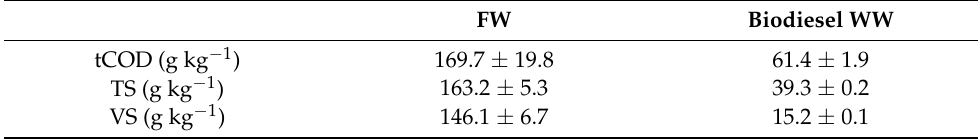
Table 1. Characterization of the substrates in g of parameter per kg of substrate.